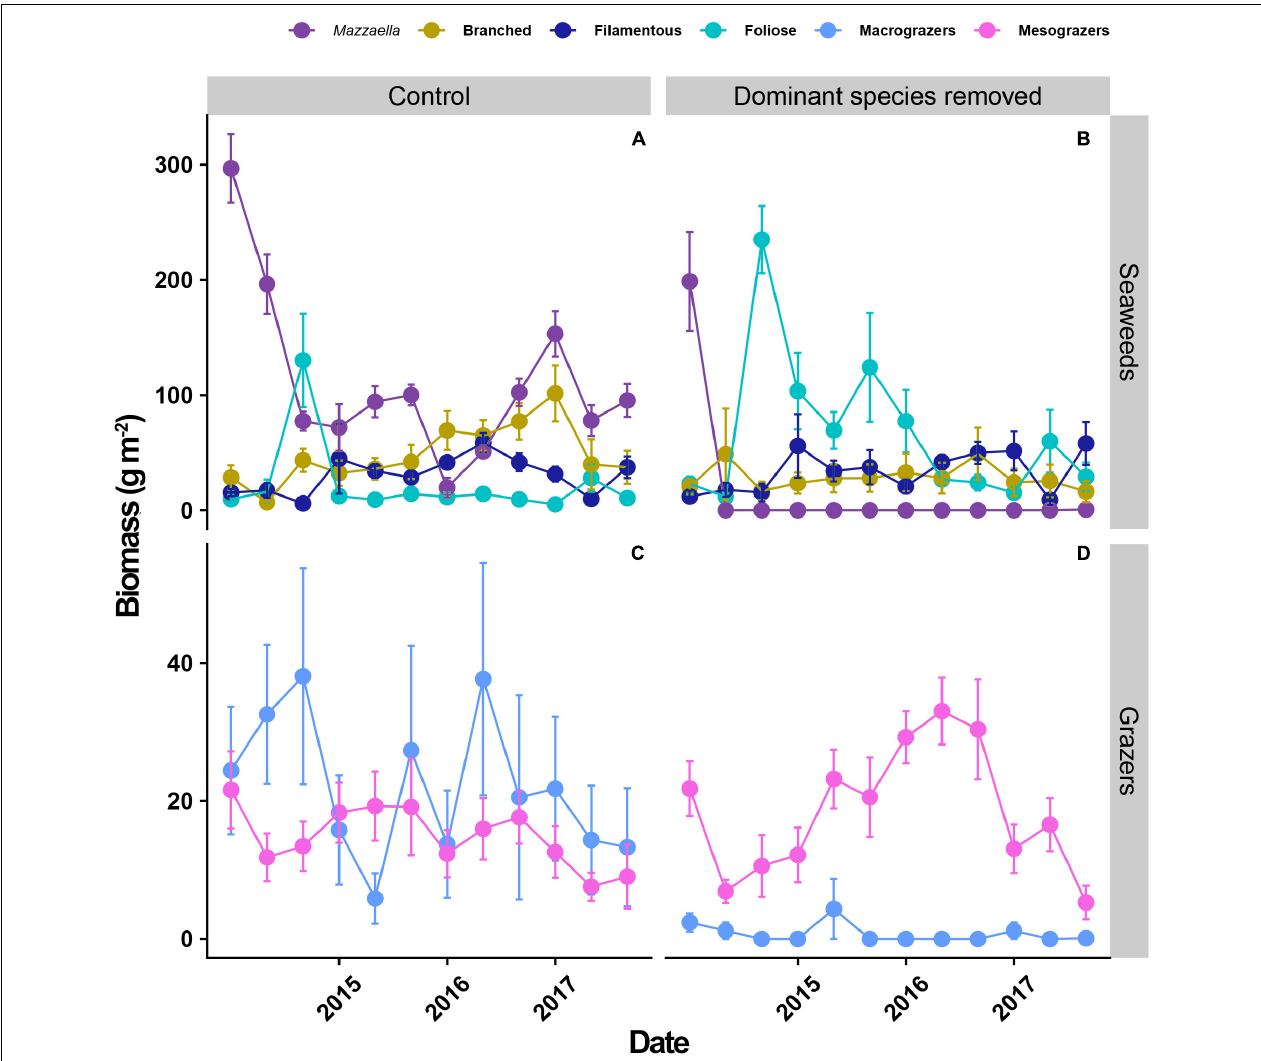
FIGURE 2 | Temporal variation in mean biomass ( ± SE) of algae (A,B) and grazers (C,D) in control (left panels) and disturbed (right panels) conditions. Algae were categorized according to morphological functional groups (canopy of Mazzaella, branched, filamentous, and foliose) and grazers according to average adult body size ( Chiton granosus, C. barnesi, Fissurella crassa, F. limbata and Fissurella sp. as macrograzers; Littorina araucana, L. peruviana, Scurria araucana, S. ceciliana, S. plana, S. variabilis, S. viridula, S. zebrina and Siphonaria lessoni as mesograzers). Each year label is positioned in May of each year (early autumn in southern hemisphere). Based on 20 experimental plots (10 control and 10